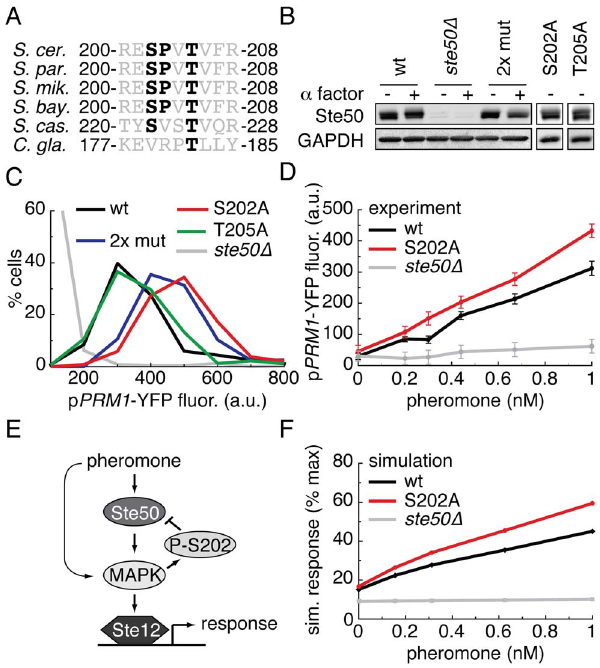
Figure 3. Phosphorylation of S202 on Ste50 inhibits pathway activity at low doses of pheromone. A. Alignment of a Ste50 tryptic phospho-peptide across 6 yeast species. Possible phosphorylation sites (serines and threonines) and minimal MAPK consensus sequences (S/ T,P) are in bold. This peptide is not within either the SAM or the RA domains. B. Western blots of lysate from yeast strains containing the indicated wild type or mutant Ste50 that had been in the absence or presence of 1 m M alpha factor for 15 minutes probed with anti-Ste50 and anti-GAPDH. C. Histograms of the single cell pheromone response measured by p PRM1 -YFP fluorescence. Cells (n . 300 cells) were treated with 1 nM alpha factor for 3 hrs followed by cycloheximide for 2 hrs, imaged by fluorescent microscopy, and quantified with Cell-ID. D. Dose responses of cells treated with 5 concentrations of pheromone as described in C. The means of the unimodal distributions are plotted. Error bars depict the standard error of the mean. E. Cartoon model of the function of the phosphorylation of S202. F. Simulation of the ODE model across a dose response of pheromone.